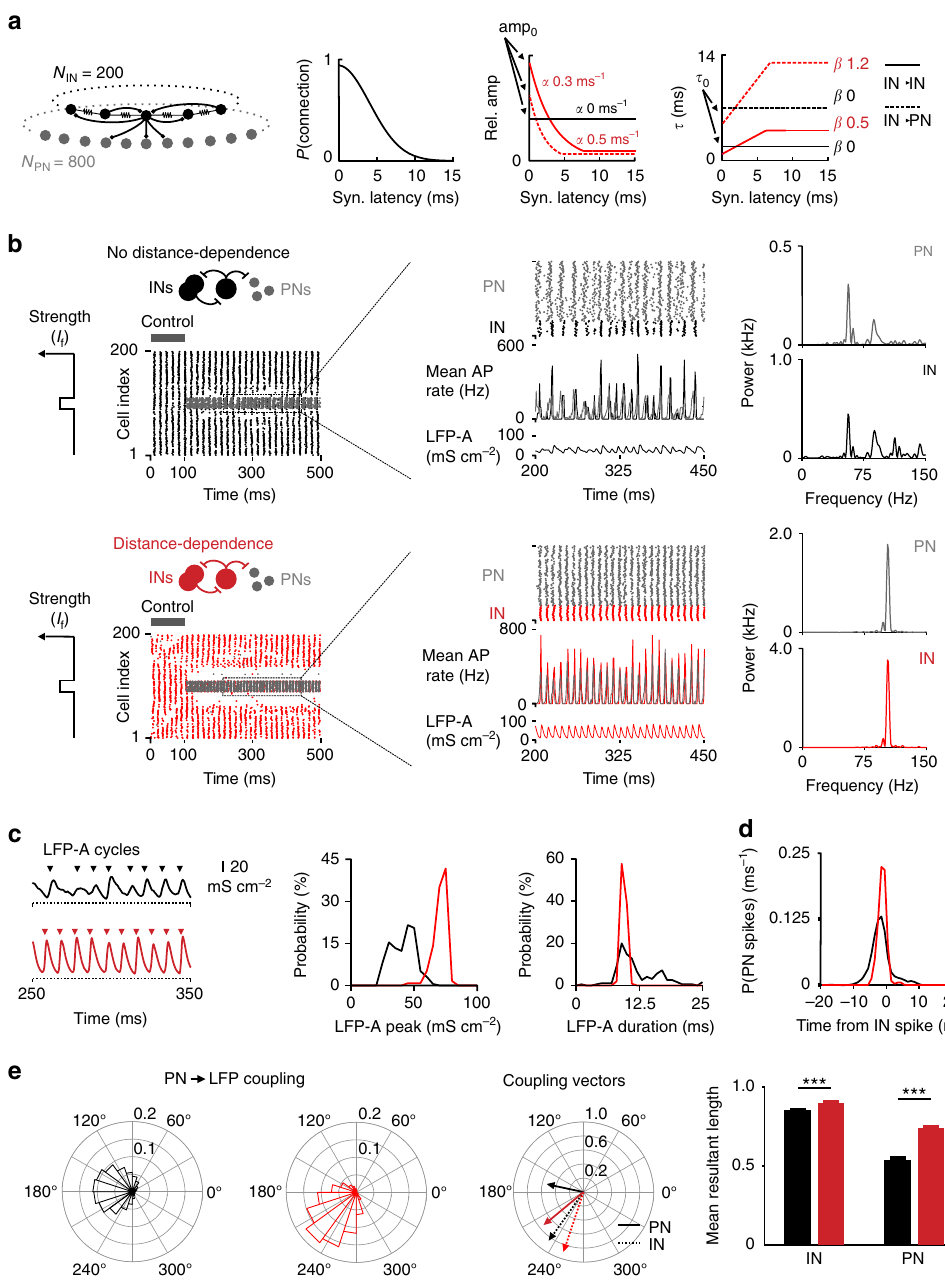
Fig. 3 Distance-dependent inhibition supports focal gamma activity. a Standard properties of the IN – PN network model. Left, circuit diagram; Gaussian IN – IN connection probability ( P ). Middle, relative uIPSC amplitude distribution normalized to the closest-neighbor connection in a noDD (black) and a DD network model (red; dashed IN – IN, continuous IN – PN connections). Note, for the noDD model, IN – IN and IN – PN connections have the same normalized amplitude distribution. Right, distance-dependent distribution of τ in a noDD (black) and a DD network model (red). Values indicate default parameters for α and β . b Left, raster plots show gamma oscillations in both networks during the control period (PN spikes (gray) and IN spikes (black/red for noDD/DD) are overlayed; PN cell index is divided by 4 to account for the PN/IN ratio). For 100 ≤ t < 500 ms, focal excitation ( I f ) was applied to the INs and PNs in the center. Middle, magni fi cation of excited cells; PN and IN spikes are separated to improve visibility. Below, AP rate histograms (1 ms bins) and summed synaptic conductances as LFP-analog (LFP-A). Right, power density estimations from PN and IN discharges shown in the middle. c Left, representative LFP-As showing subsequent gamma cycles recorded from focally excited PNs in both models. Arrowheads indicate beginning of individual gamma cycles. Right, distributions of amplitude and length of individual LFP-A cycles from 10 simulation runs. d Probability ( P ) of PN spikes at different time points relative to the maximum of IN activity of the closest gamma cycle. Note, stronger PN – IN spike coupling in DD model ( N = 10 simulation runs, spikes from 80 PNs). e PN coupling to the LFP-A. Left, mean normalized angle histograms of PN spikes to LFP-A phase (0° at LFP-A peak). Middle, mean resultant coupling vectors for IN (dashed) and PN (continuous) spikes, with angle and length corresponding to the phase and strength of single action potential coupling, respectively. Right, in the DD network PNs couple more strongly to the inhibitory LFP-A. Bars and error bars represent mean and SEM from 10 simulation runs (spikes from 80 PNs and 20 INs). *** p < 0.001; two-tailed, two-sample t